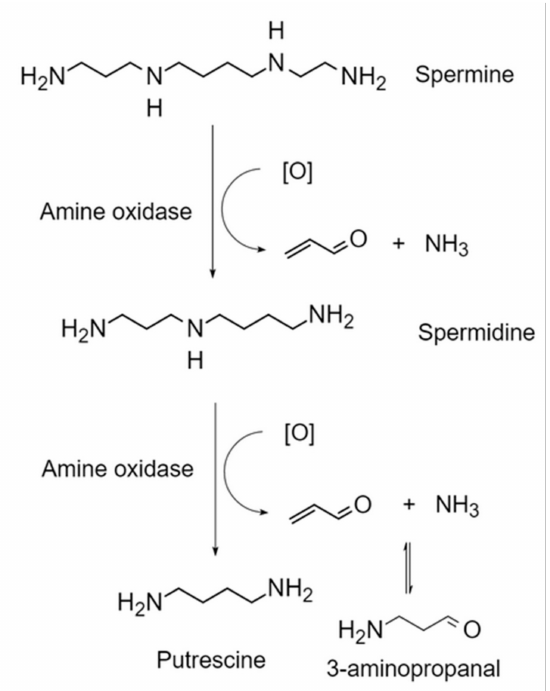
Figure 2. The pathway of acrolein production by spermine catabolism.